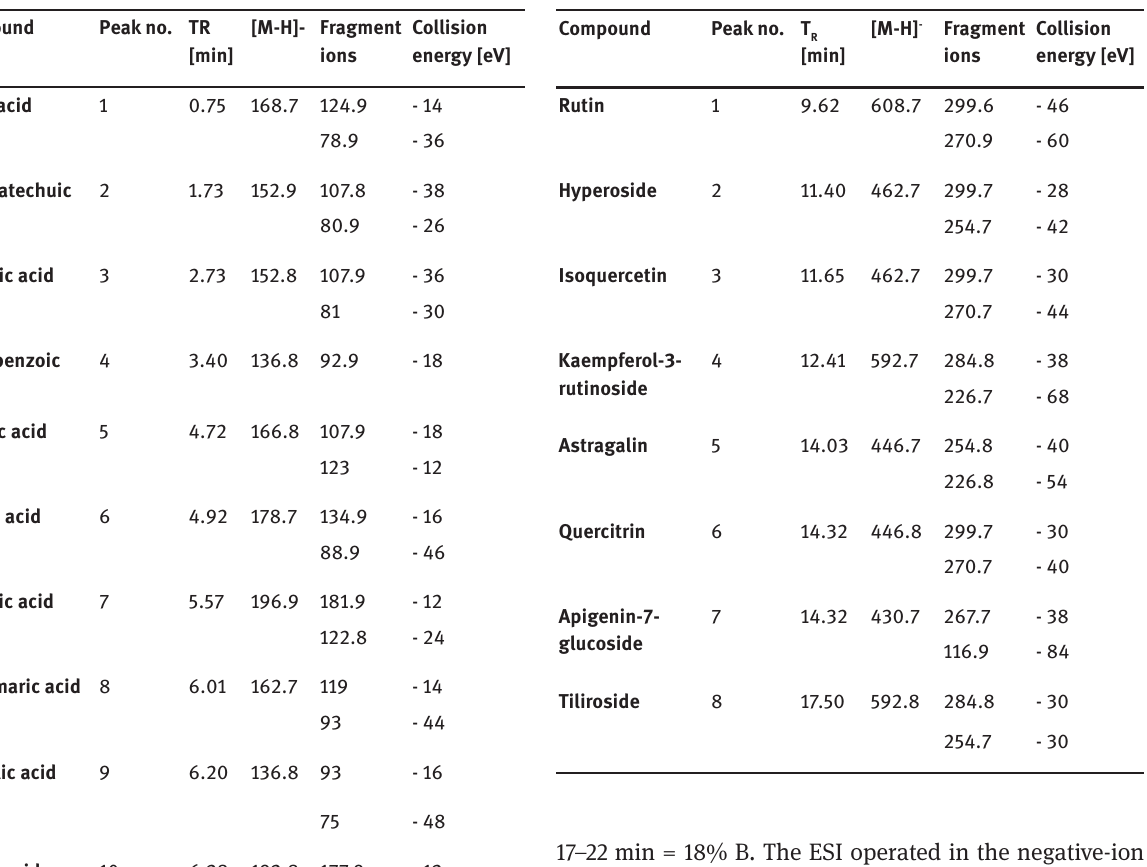
Table 2: LC-ESI-MS/MS flavonoid glcosides